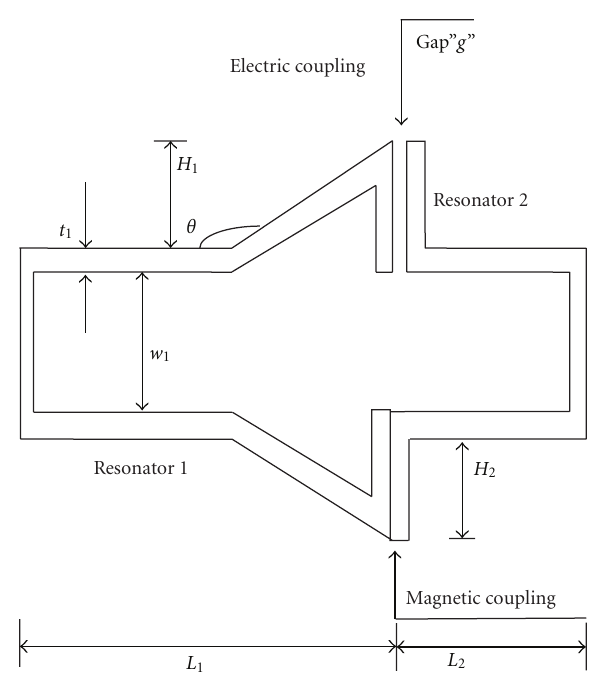
Figure 5: Coupled resonators.